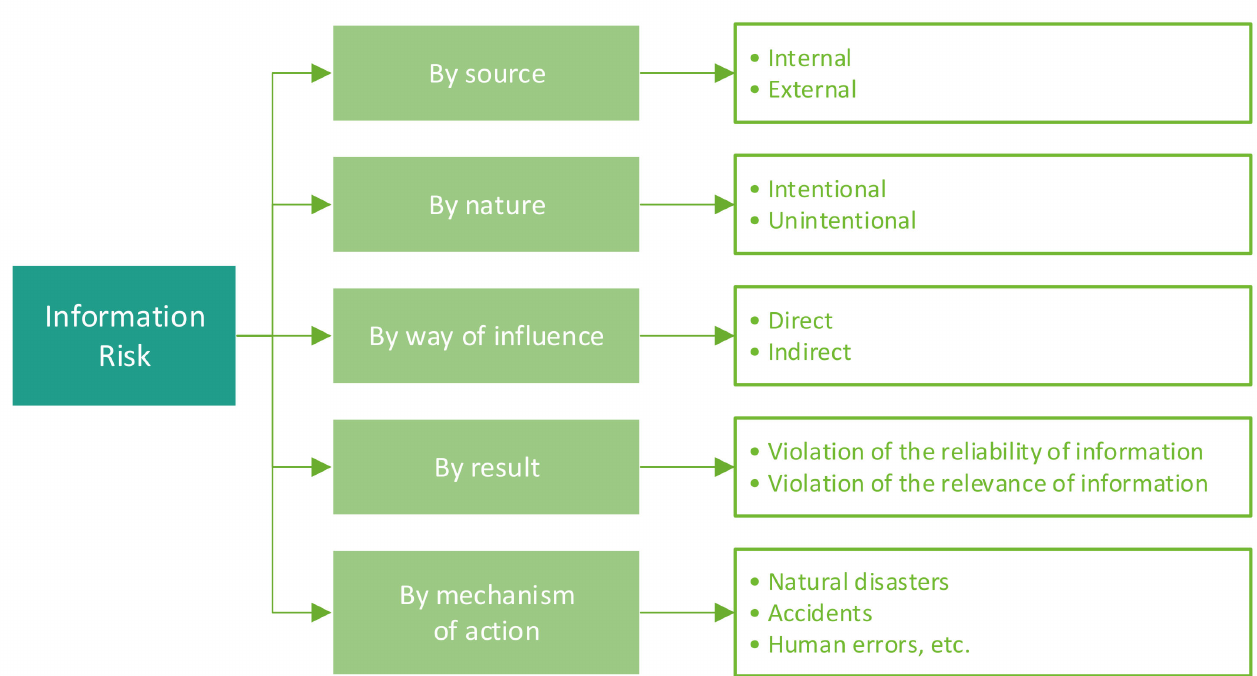
Figure 1. Classification of information